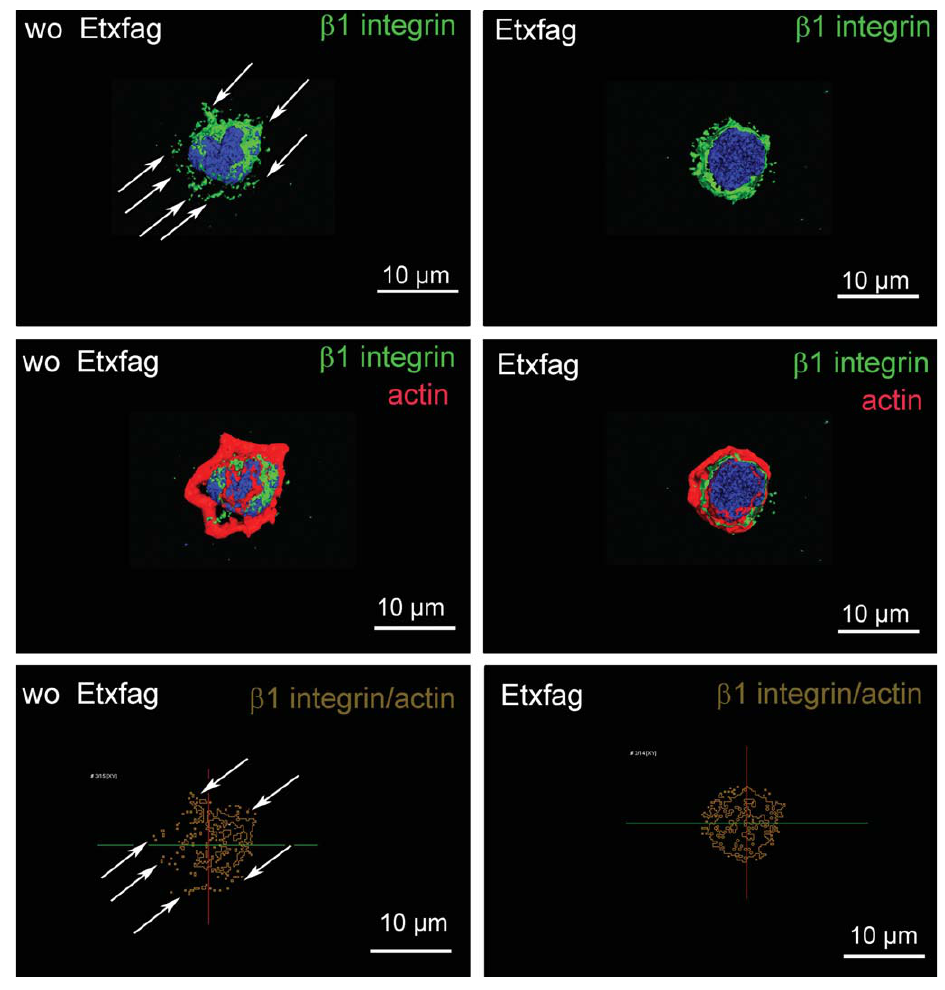
Fig. 3. Etxfag alters (cid:1) 1 integrin clustering and actin cytoskeleton expansion in L1210 cells. L1210 cells treated or not with 1 × 10 − 7 M etxfag during 24h were seeded on FN/V-coated glass culture slides in serum-free medium for 2h. Cells were fixed with 4% paraformaldehyde then incubated with anti- (cid:1) 1 primary antibody (1:100) and labelled with secondary antibody linked to Alexafluor 488 (green). Cells were also incubated with Alexafluor 568-conjugated phalloidin (red) to visualize F-actin distribution. Emitted fluorescence was detected through the appropriate wavelength window. Twenty images were captured with a 0.25 (cid:3) m z-step. Surfacic reconstructions were realized from L1210 cells treated with or without etxfag (right and left row, respectively). Upper panels represent (cid:1) 1 integrin labelling, middle panels represent (cid:1) 1 integrin+F-actin labelling and bottom panels represent colocalization of (cid:1) 1 integrin and F-actin (gold). A representative image of three independent experiments was